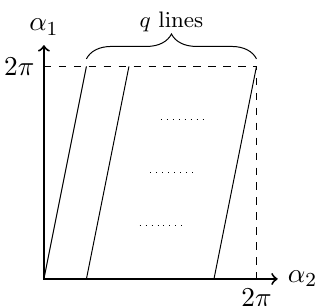
Figure 4 . The elements of the subgroup (A.6) highlighted in solid black on the toroidal U(1) 2 group manifold. Vertically level points on the top and bottom edges of the square are the same, as are the horizontally level points along the left and right edges of the square. See also the similar depictions in